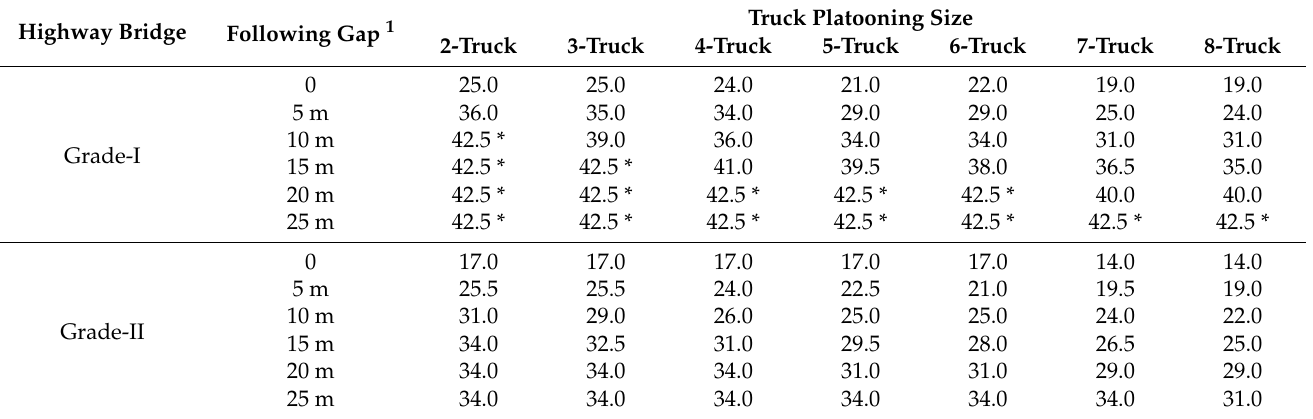
Table 4. Suggested upper mass limits (t) for platooning trucks under different